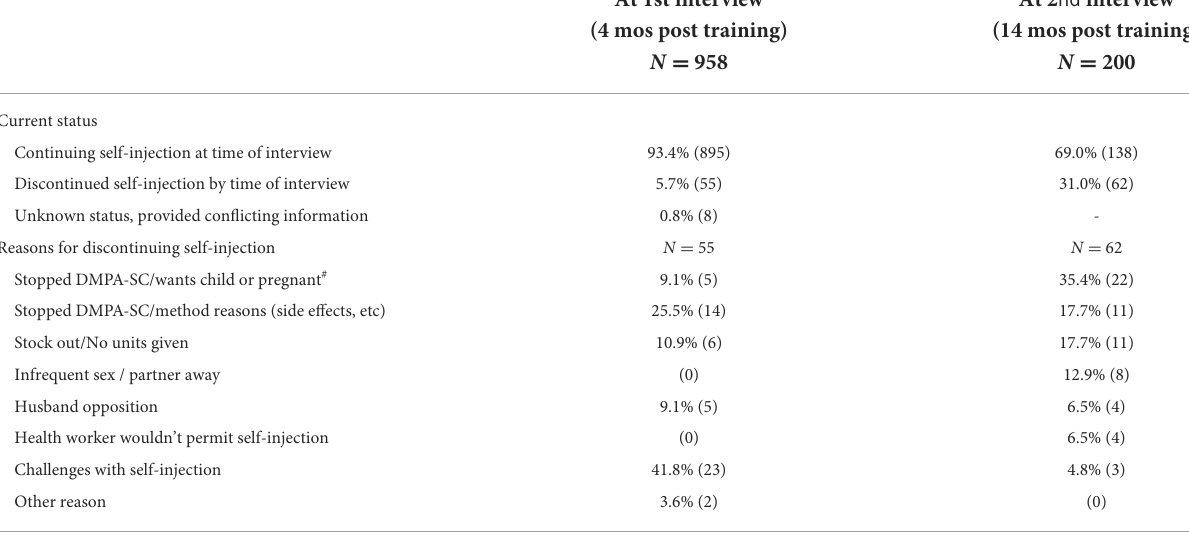
TABLE 4 Continuation and reasons for discontinuation of